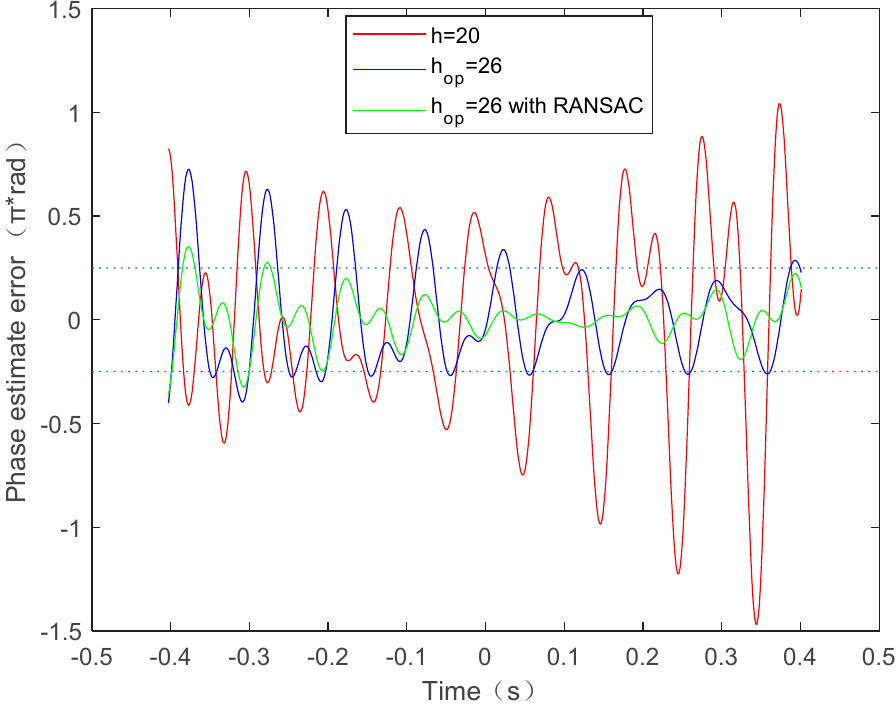
Figure 11. Phase estimate error.